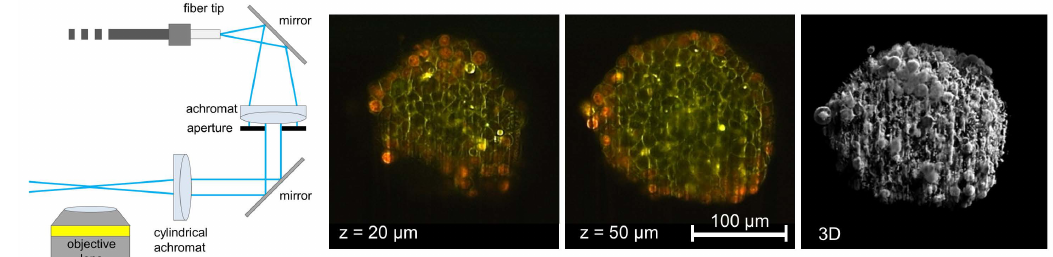
Figure 9. 3D imaging of MCF-7 cell spheroids after incubation with doxorubicin (8 µ M, 6 h). Light Sheet Fluorescence Microscopy (LSFM) using rectangular micro-capillaries (scheme, 2 single planes and 3D reconstruction); beam waist: ∆ z = 5–10 µ m, focal depth: ∆ y = 100–200 µ m.